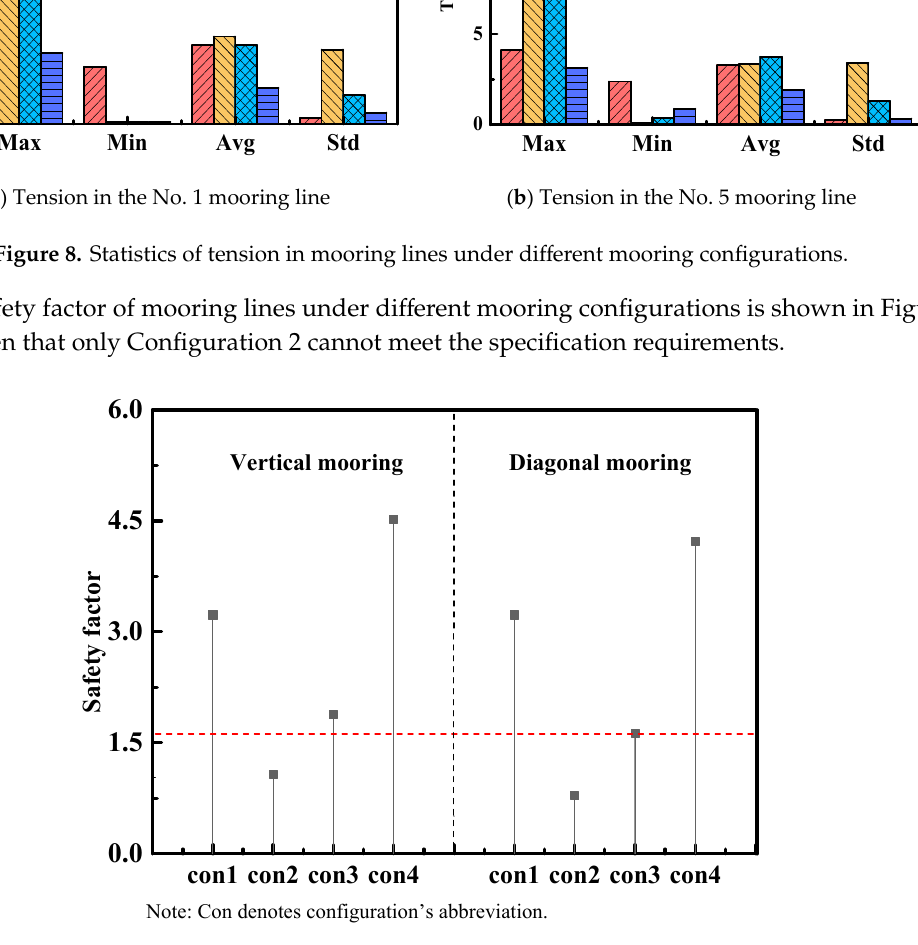
Figure 9. Safety factor of mooring lines under different mooring configurations.